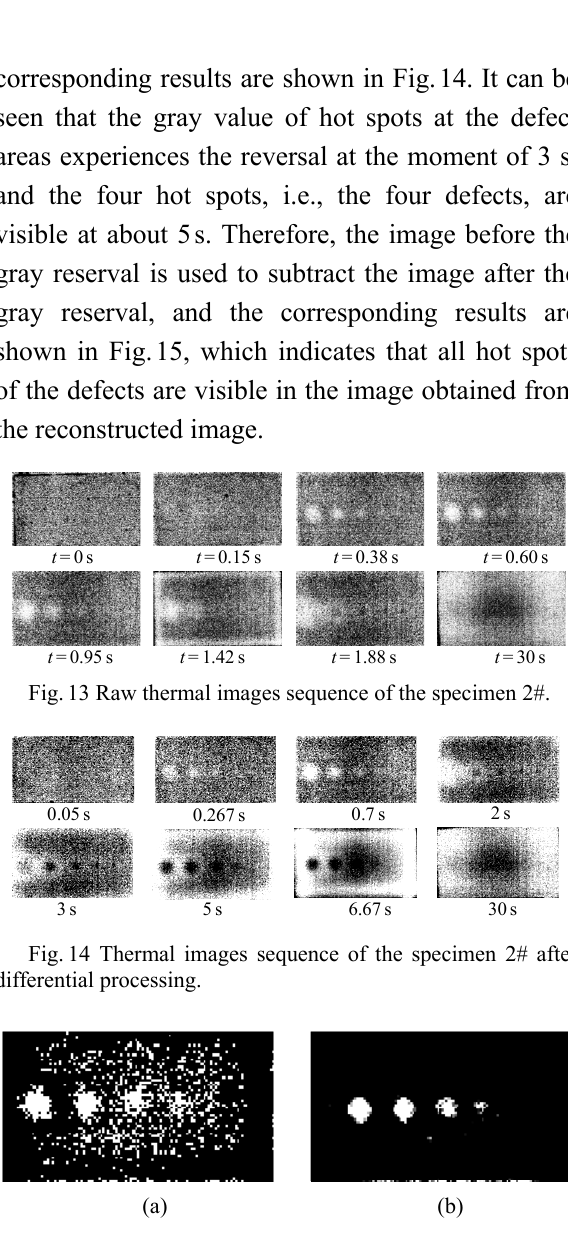
Fig. 15 Results of images processing by subtracting the gray reserval and denoising: (a) result of image before the gray reserval subtracting image after the gray reserval, and (b)